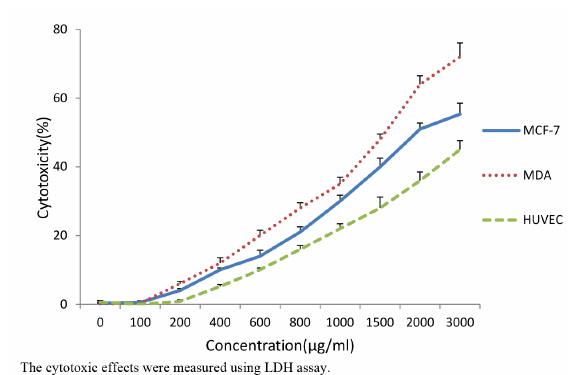
Figure 2. The Investigation of the Inhibition of MCF-7, MDA-231, and HUVEC Cells Growth Using the MTT Assay Data are presented as mean ± SEM of three independent